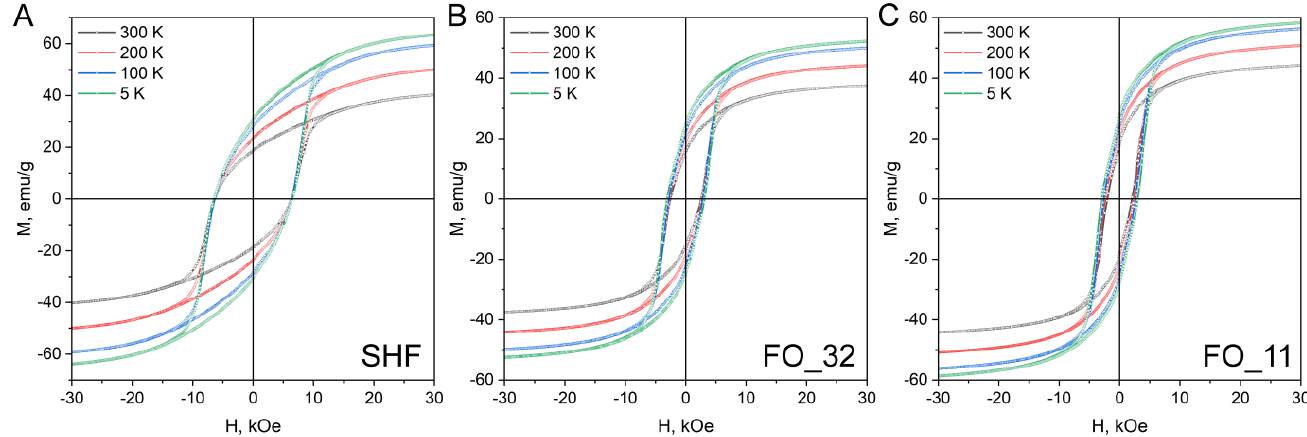
Figure 5. Hysteresis loops of the uncovered SrFe 10 Cr 2 O 19 (SHF) nanoparticles and composite samples (FO_32 and FO_11) at different temperatures (5, 100, 200 and 300 K).